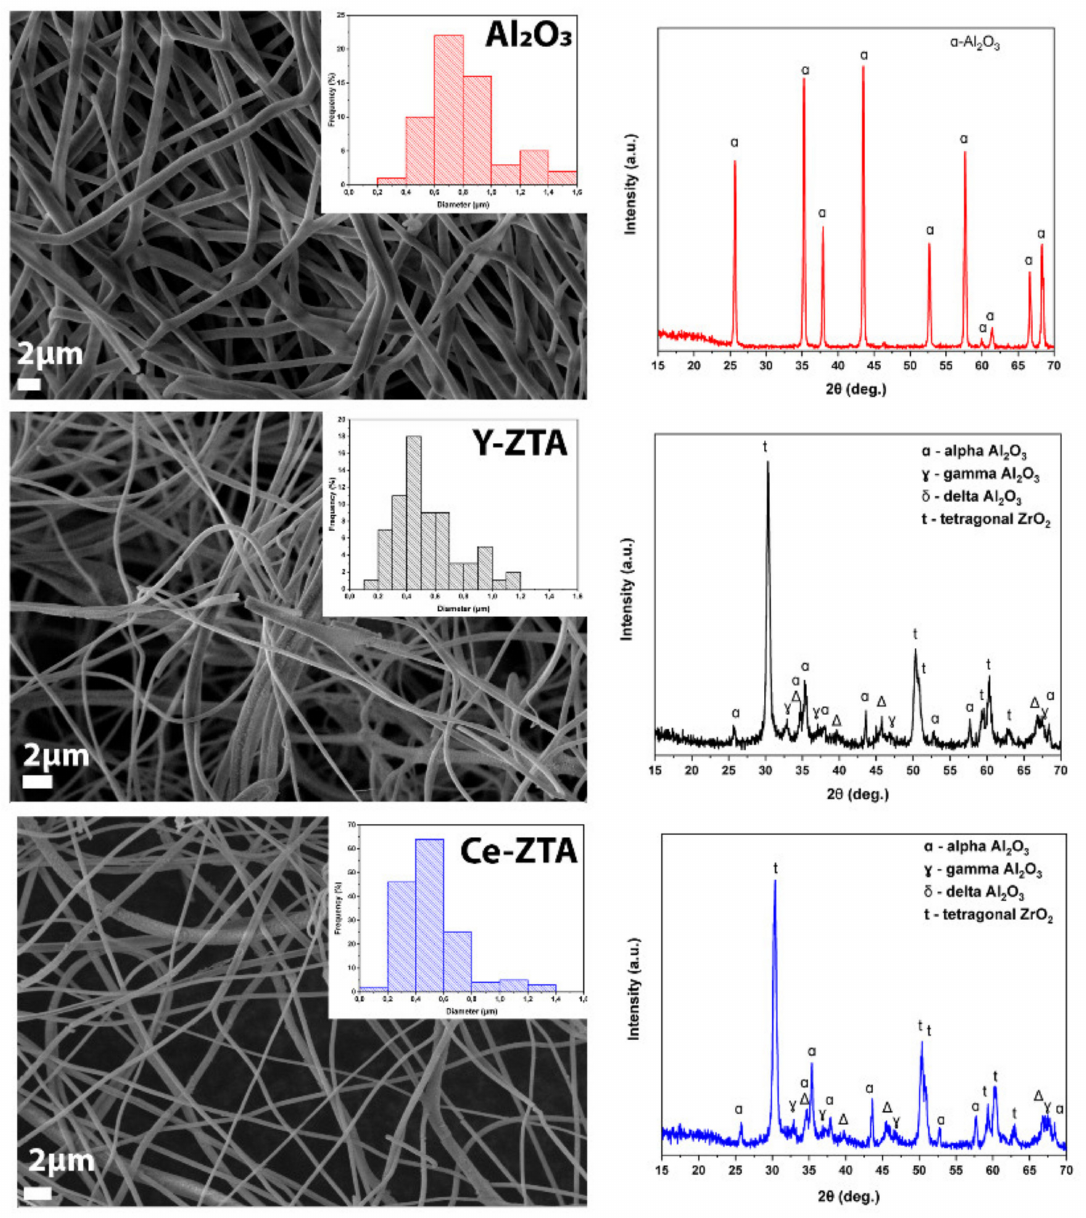
Figure 2. Characterisation of reference fibres by SEM and XRD analysis